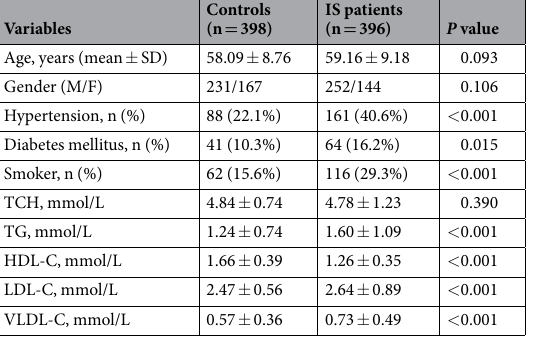
Table 1. Clinical characteristics of the study population. IS, ischemic stroke; SD, standard deviation; M, male; F, female; TCH, total cholesterol; TG, triglyceride; HDL-C, high density lipoprotein-cholesterol; LDL-C, low density lipoprotein-cholesterol; VLDL-C, very low density